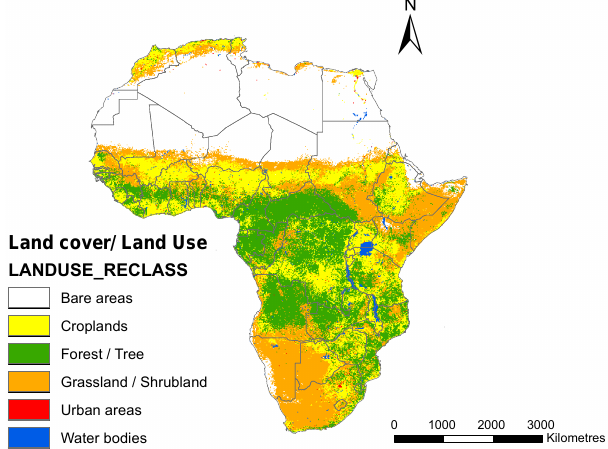
Figure 4. Land cover/land use map of Africa (modified from De- fourny et al.,